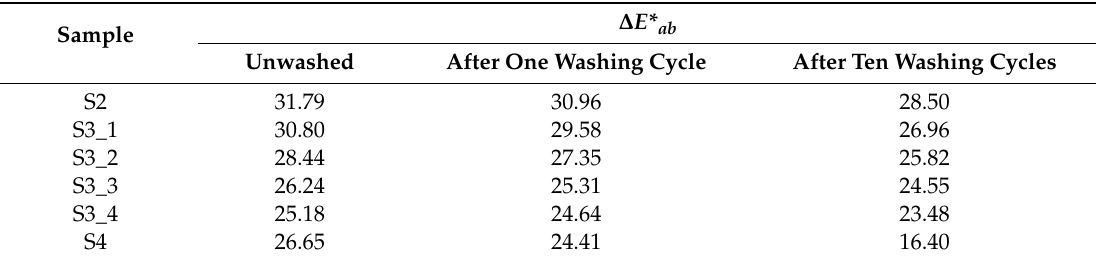
Table 7. Colorfastness to domestic and commercial laundering.